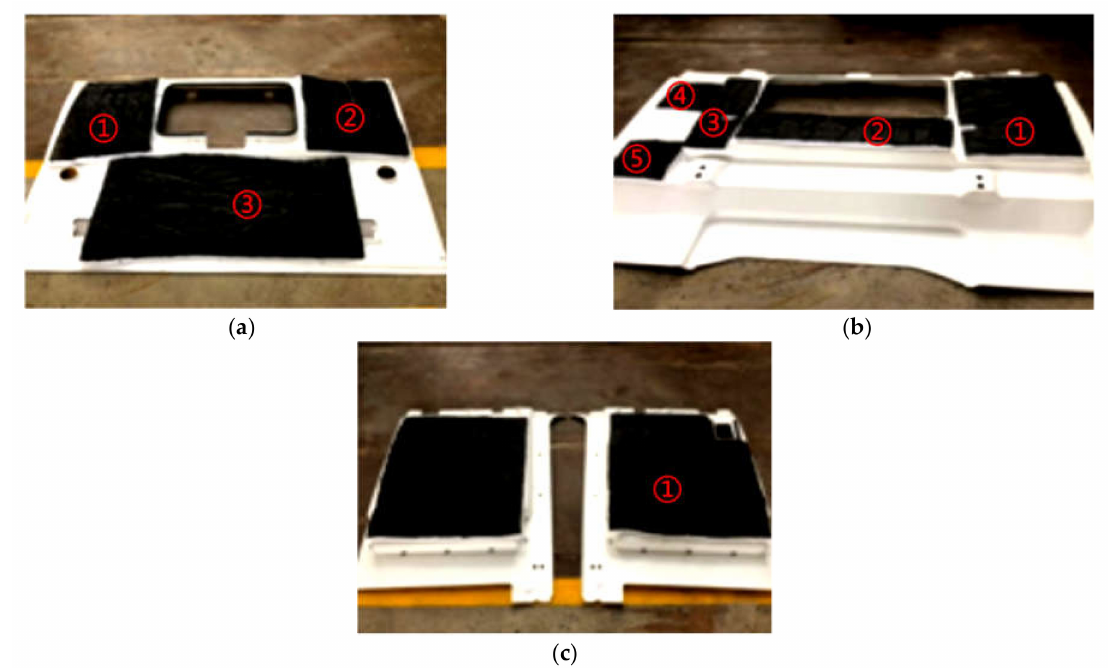
Figure 17. The layout of the acoustic package for the cab. ( a ) Acoustical optimization scheme for lining sound-absorbing cotton; ( b ) optimization scheme for surrounding sound-absorbing cotton at the back; ( c ) Acoustical optimization scheme for surrounding interior panel at the